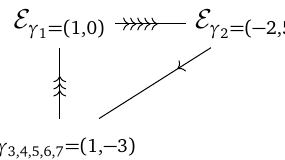
Figure 22: Fundamental domain for Γ 1 ( 5 ) , with ( I i ∞